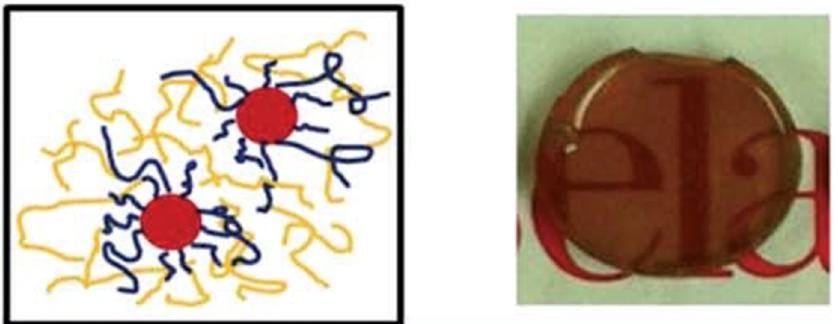
Figure 6. Electroluminescent transparent quantum dot composites (Tao) [85]. Left: depiction of macromers (blue) modifying a CdSe QD (red) in a silicone matrix; Right: specimen of composite. (Reprinted with permission from Ref. [85] Copyright 2013 the Royal Society of Chemistry).